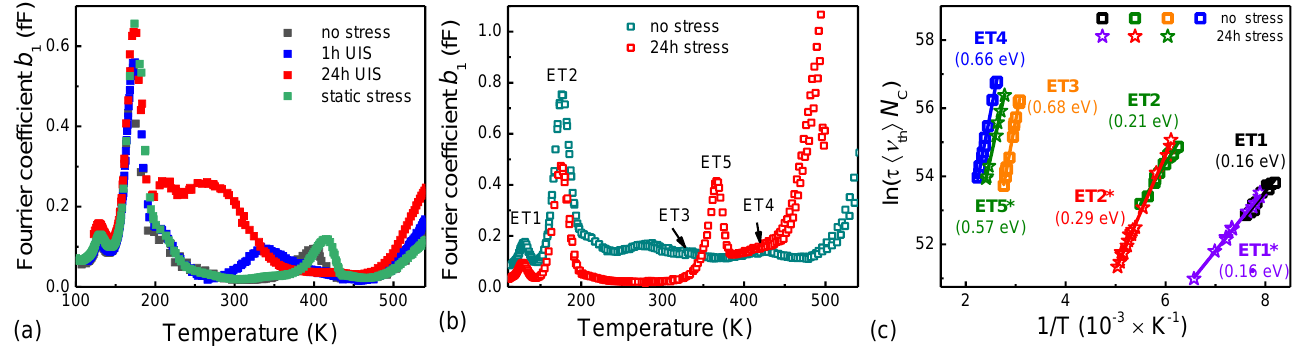
Figure 6. ( a ) Comparison of the Fourier coefficient b 1 spectra induced by different stress conditions and ( b ) for the virgin device and after repetitive UIS stress with a duration of 24 h. ( c ) Arrhenius plot of evaluated trap states.